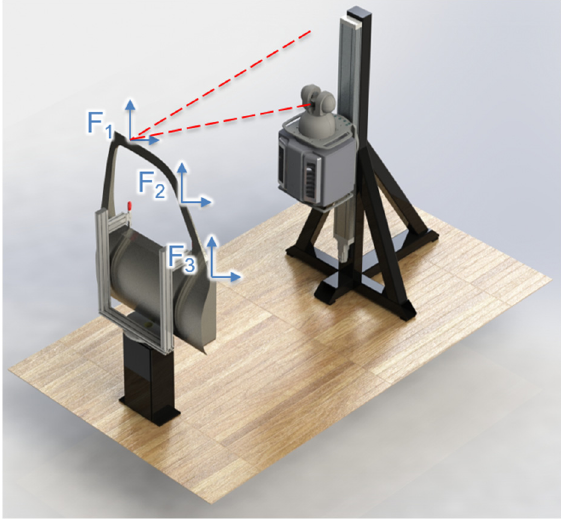
Figure 27. Early virtual illustration example of the 3D scene in IPS LR application for task planning.